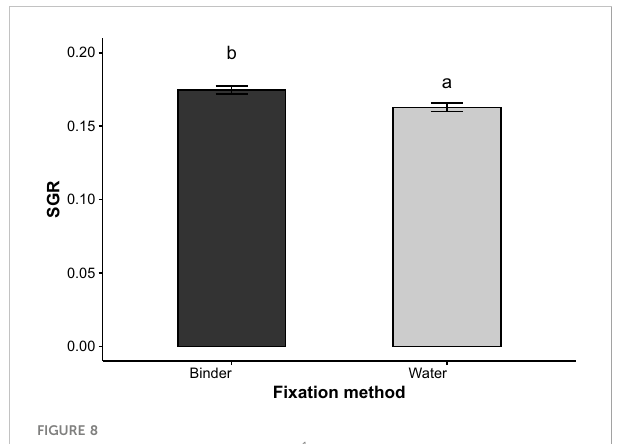
FIGURE 8 Speci fi c growth rate (SGR, % day -1 ) of S. latissima between days 14 and 35 according to the fi xation method; bars with different letters are signi fi cantly different (p< 0.05), n = 3.